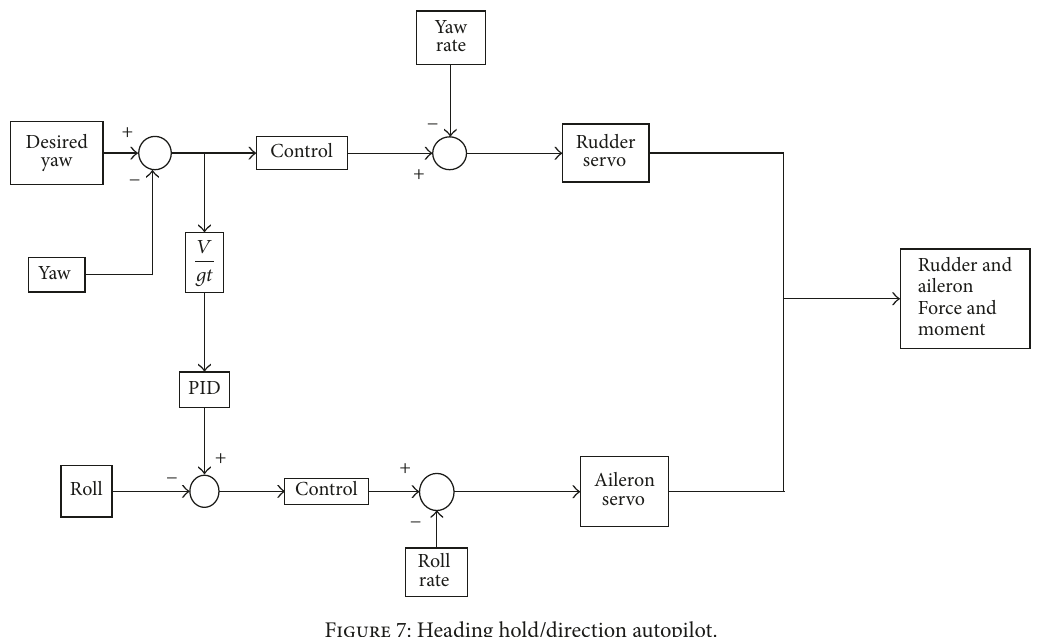
Figure 7: Heading hold/direction autopilot.